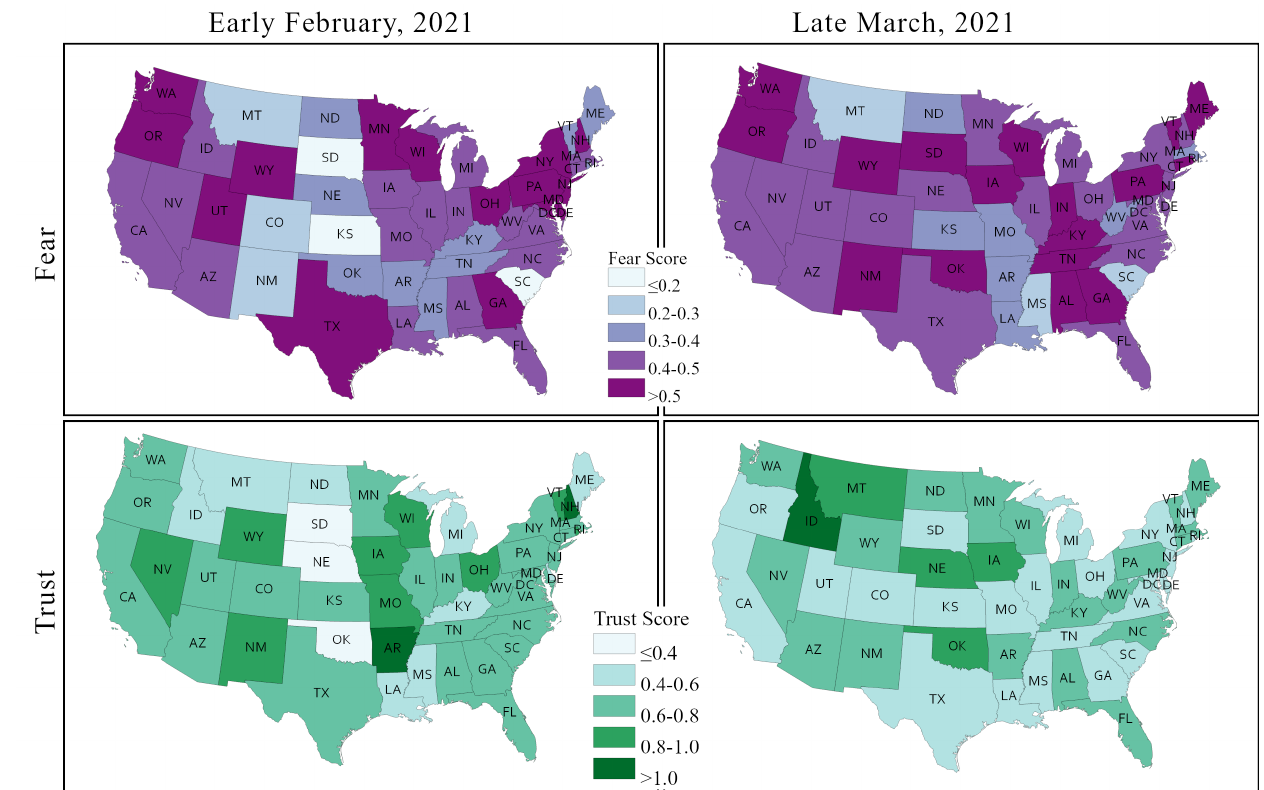
Figure 12. Changes in fear and trust sentiments in US